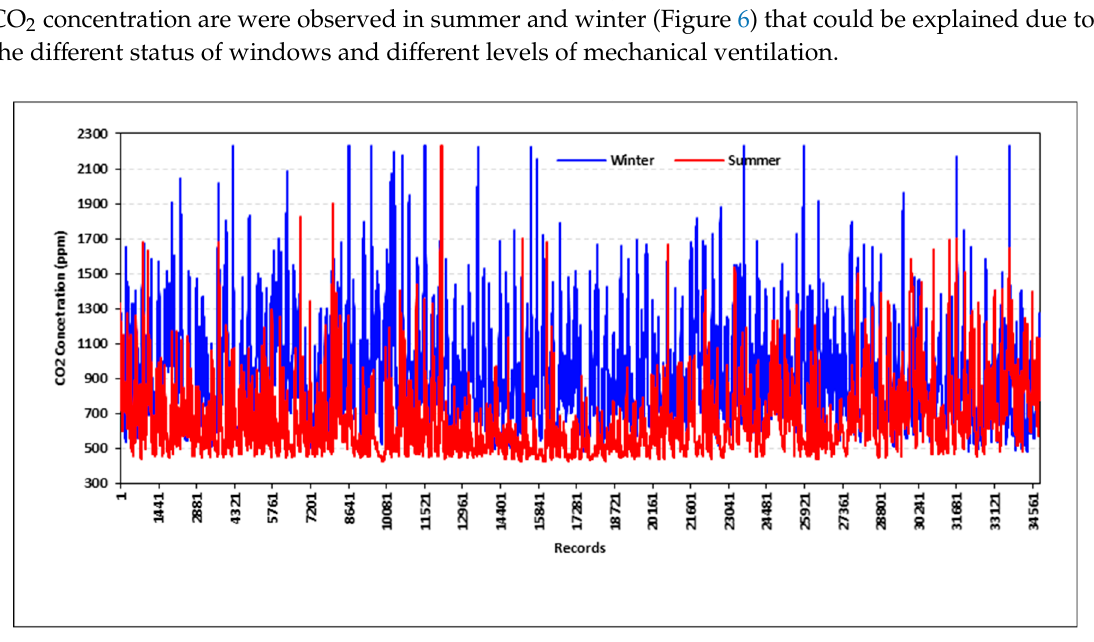
Figure 6. Overview of CO 2 concentration for summer and winter.